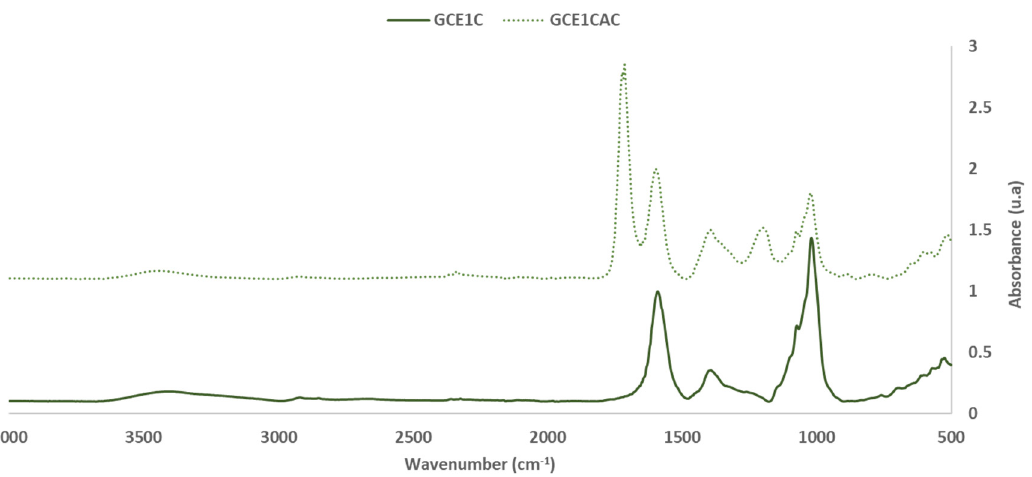
Figure 5. FTIR spectra: Grape cane extracts GC E1 , cured alone GC E1 C, and with citric acid GC E1 CAC (400–4000 cm − 1 ).